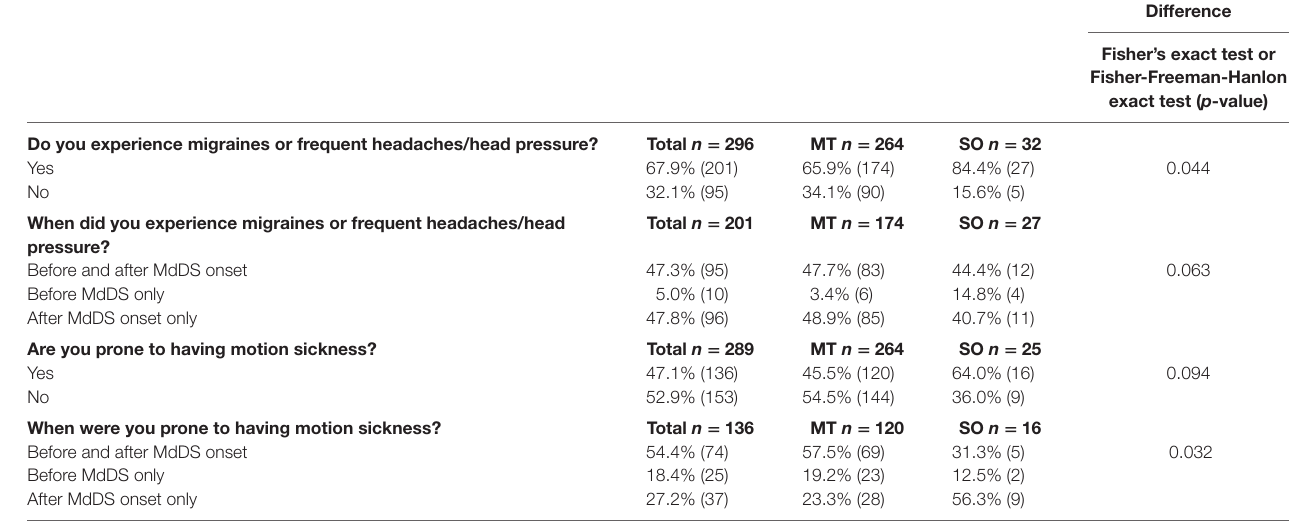
Table 7 | Reported migraine and motion sickness experience with relation to MdDS onset presented as a percentage of the group and raw number.